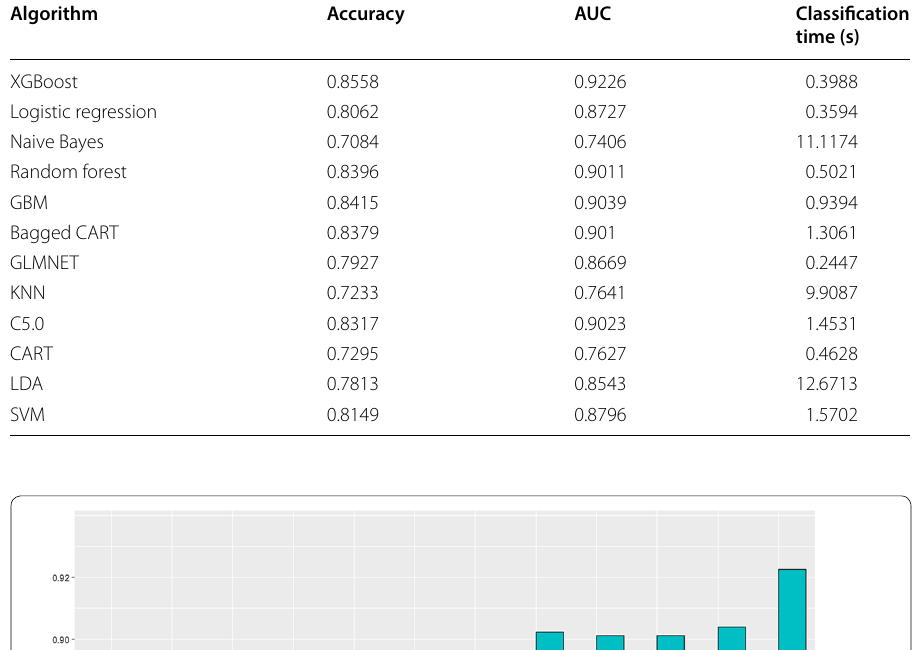
Table 5 Results for gender prediction